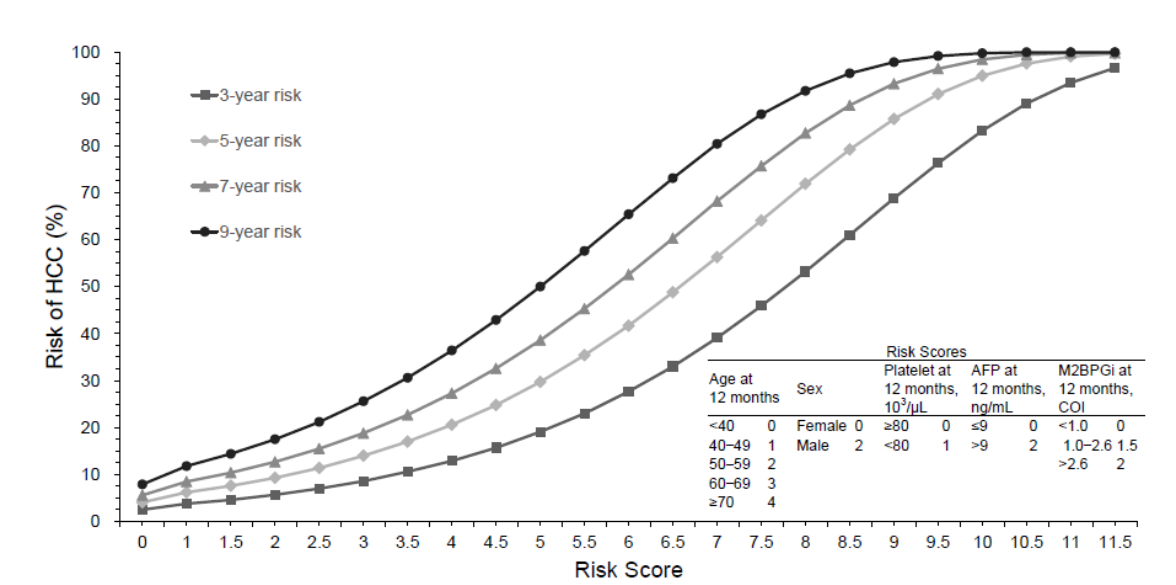
Figure 2. Nomograms for the prediction of the risk of hepatocellular carcinoma development. We categorized the ASPAM-B score into three subgroups according to the HCC in- cidence: ≤3.5, 4– 7 and >7, respectively. The cumulative HCC rates at 8 years of treatment in the three subgroups were 9.0%, 23.5% and 57.9%, respectively ( p < 0.001, Figure 3A).